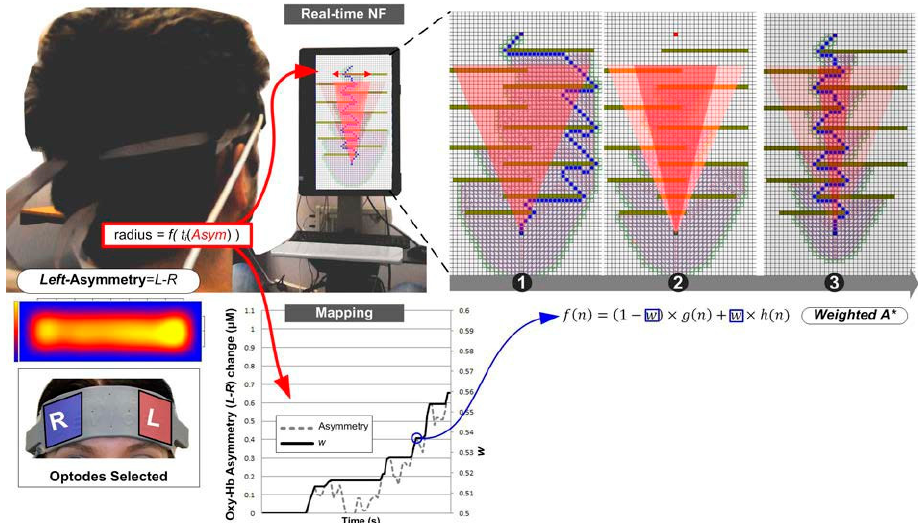
Figure 6. BCI interfacing to heuristic search on a path planning problem. The motivational dimension is acquired through fNIRS-based prefrontal cortex asymmetry. In this experiment, the heuristic function can be repeatedly modified as the search progresses, also taking advantage of the more visual feedback provided by path progression. Because of the multiple updates, in this experiment the weighting factor has only been allowed to increase through time to explore search speed-up. Note the change in the qualitative nature of the solution (path geometry) from solution (1) to solution in (3). From [71].